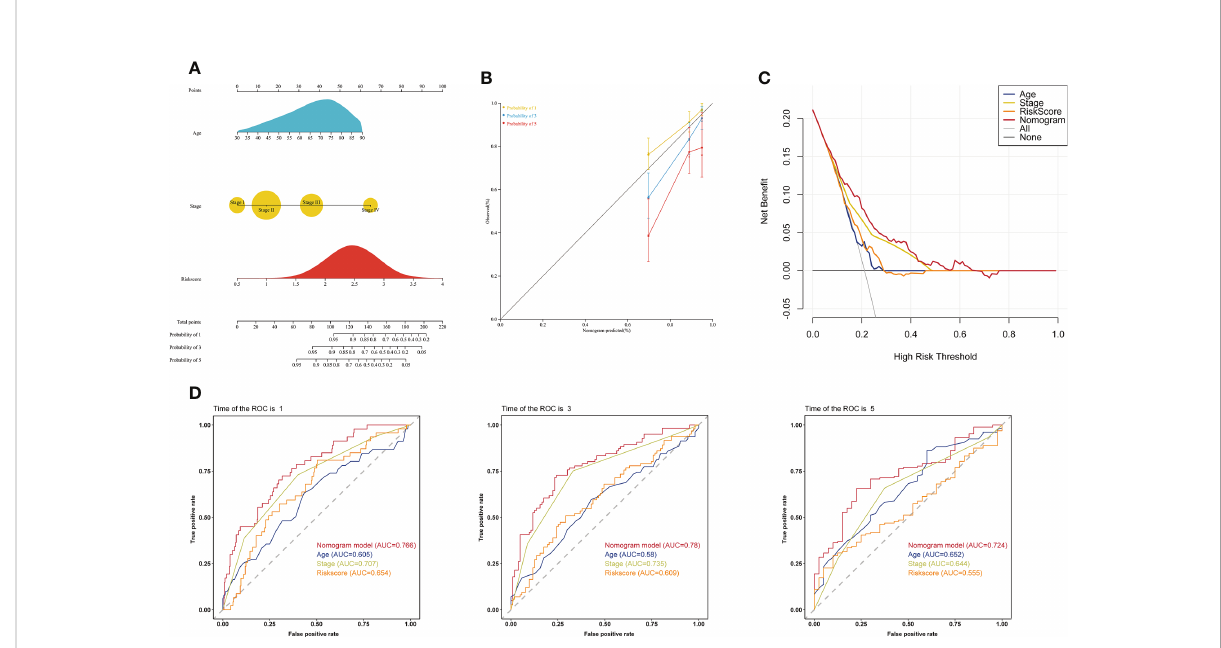
FIGURE 6 Establishment of a clinical prognostic nomogram. (A) Clinical prognostic nomogram integrating clinical factors and the risk score. The scores for each predictor were summed to obtain total points to predict the patient ’ s OS at 1, 3, and 5 years. (B) Calibration curves of the clinical prognostic nomogram for predicting 1-, 3-, and 5-year OS. The X-axis represents the predicted patient survival rate, and the Y-axis represents the actual patient survival rate. (C) DCA of the clinical prognostic nomogram. (D) ROC curve of the clinical prognostic nomogram for predicting 1-, 3-, and 5-year survival in COAD